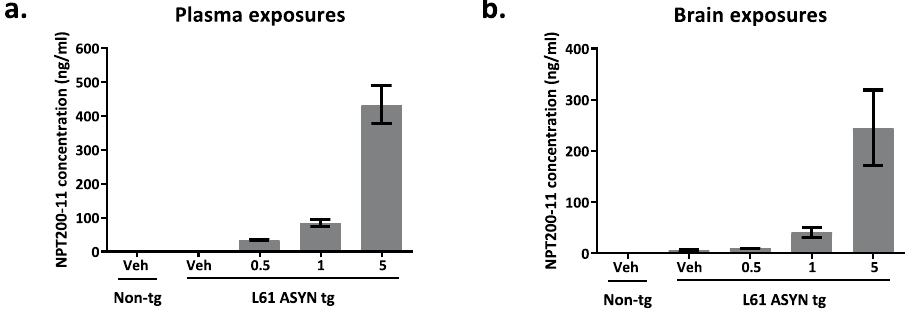
Figure 3. Bioanalysis of NPT200-11 exposures in non-transgenic and Line 61 ASYN transgenic mouse plasma and brain homogenates from the 3 month efficacy study. Genotype and treatment group (vehicle or NPT200-11 in mg/kg) are denoted along the x-axis. Graphed values represent the mean concentration of NPT-200-11 (ng/ ml) ± SEM for 11–25 animals per group. The group statistics are summarized in Table 2.